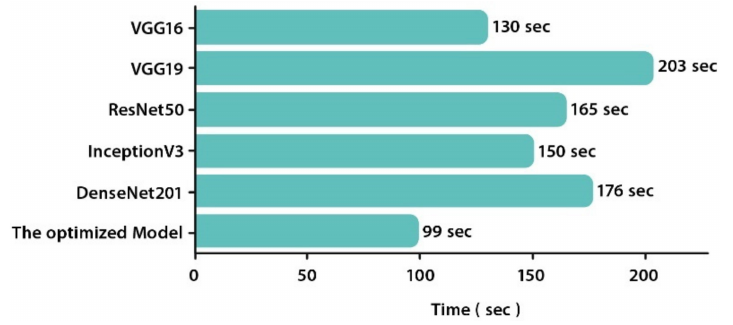
Figure 17. Execution time of all CNNs on